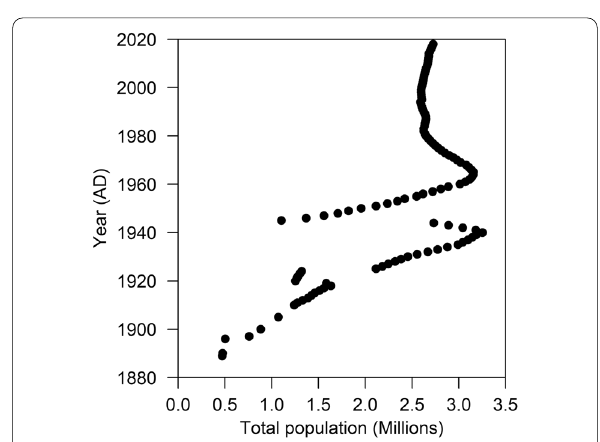
Fig. 11 Total population of Osaka City. Note that the sudden decline in the population around 1920 was caused by a tripling of the city area due to an amalgamation with other areas. Source: Osaka